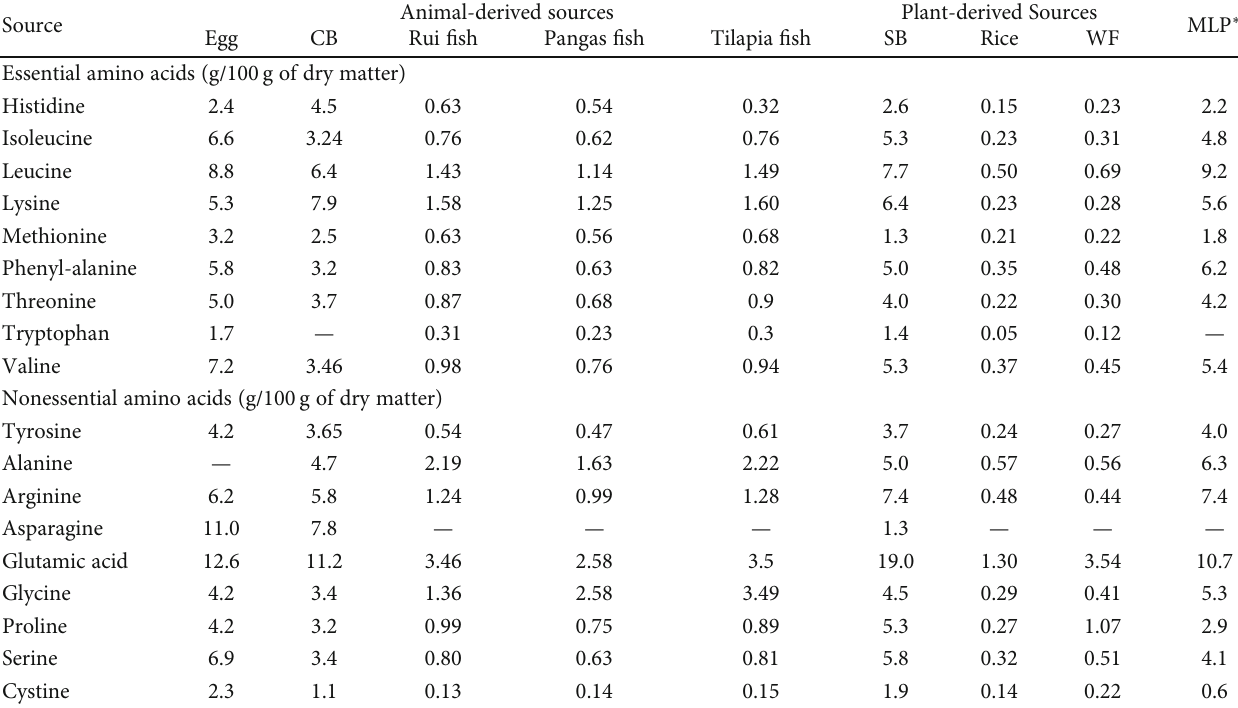
Table 4: Amino acid pro fi le of di ff erent protein sources compared with Moringa leaf powder. Source